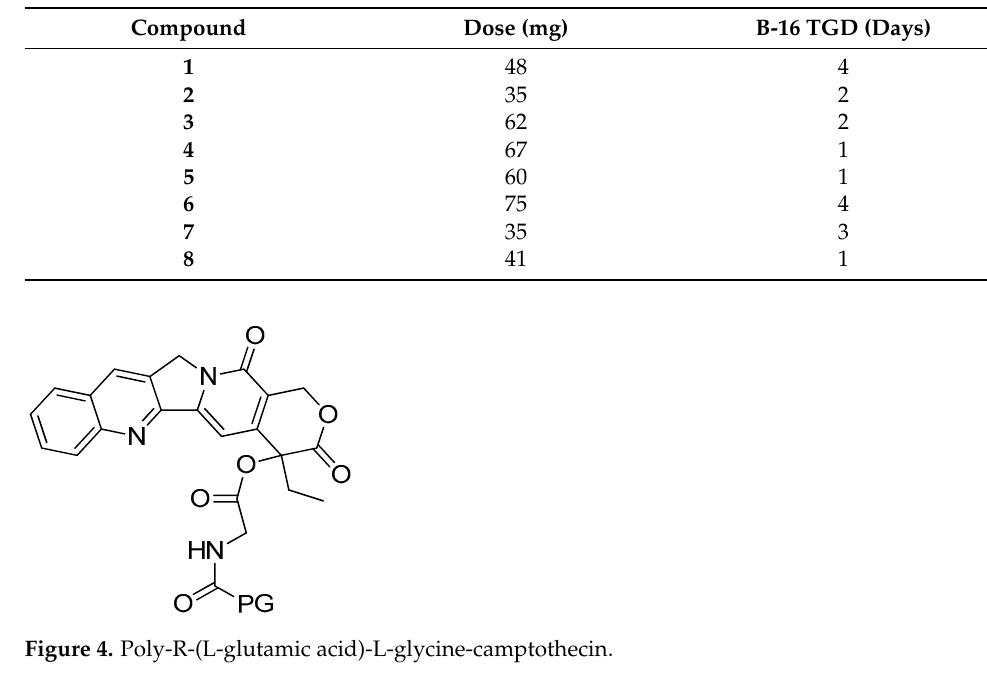
Table 2. Effects of poly-R-(L-glutamic acid) conjugates of camptothecin on the in vivo growth